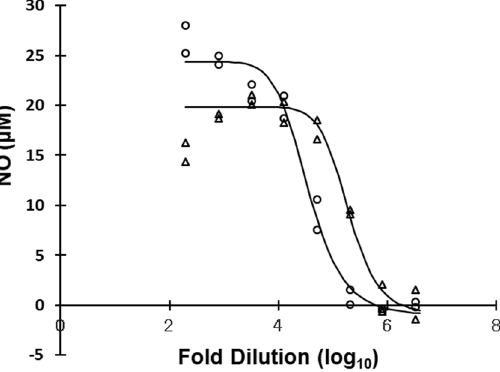
Figure 1. NO production activities stimulated by the addition of B. mori (circle) and A. yamamai (triangle) pupae to the culture medium of RAW264